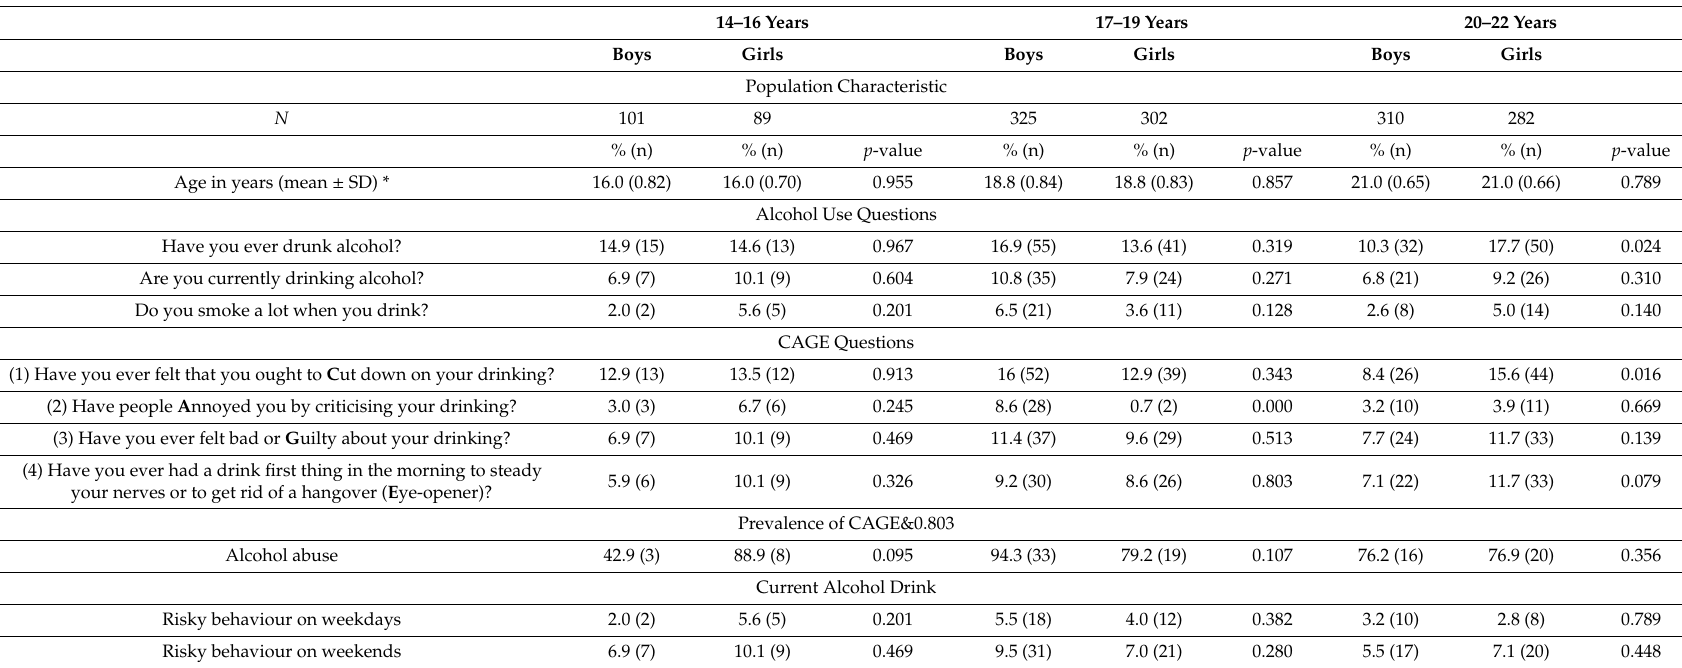
Table 1. Prevalence of alcohol usage and CAGE among Ellisras rural adolescence and young adults aged 14–22